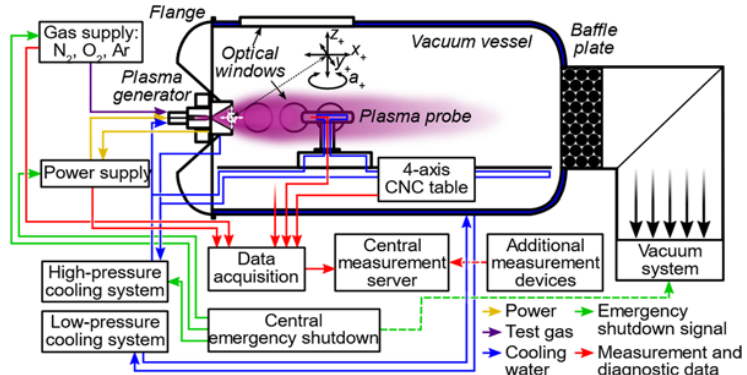
Figure 4. Functional schematics of IRS Plasma Wind Tunnel test facility in operation.